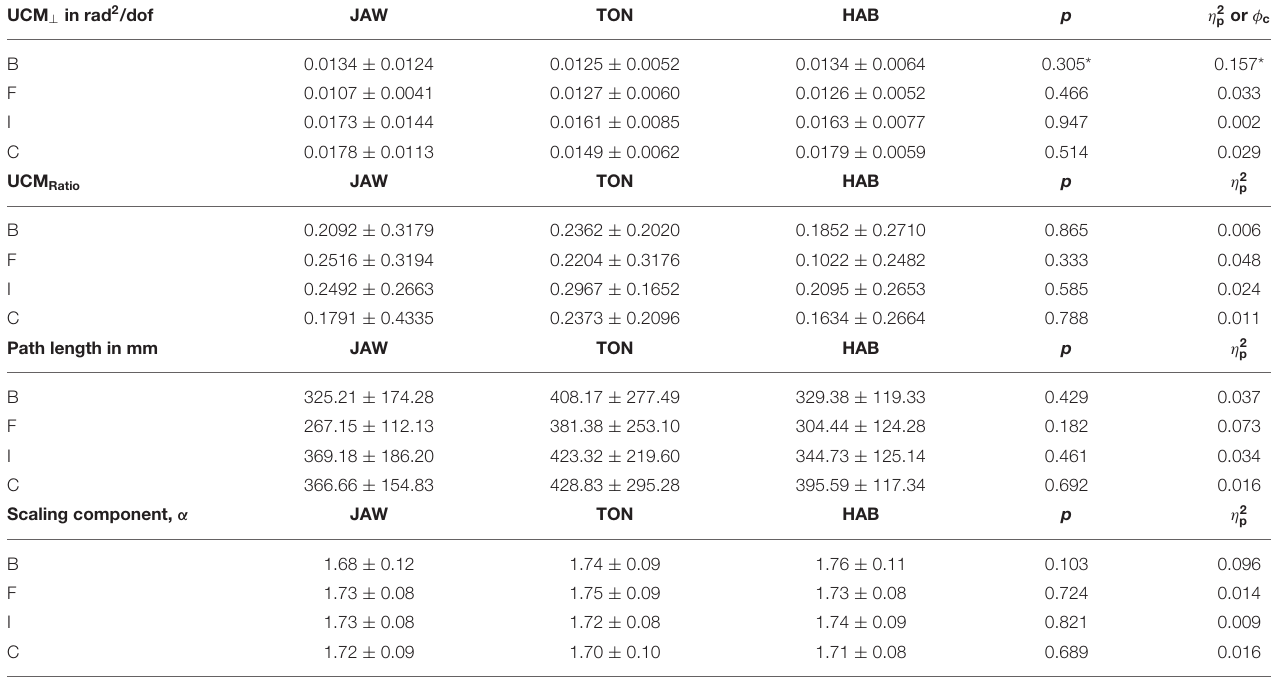
TABLE 2 | The UCM, the path length and the DFA scaling exponent ( α ) results are shown as mean ± standard deviation. UCM ⊥ in rad 2 /dof